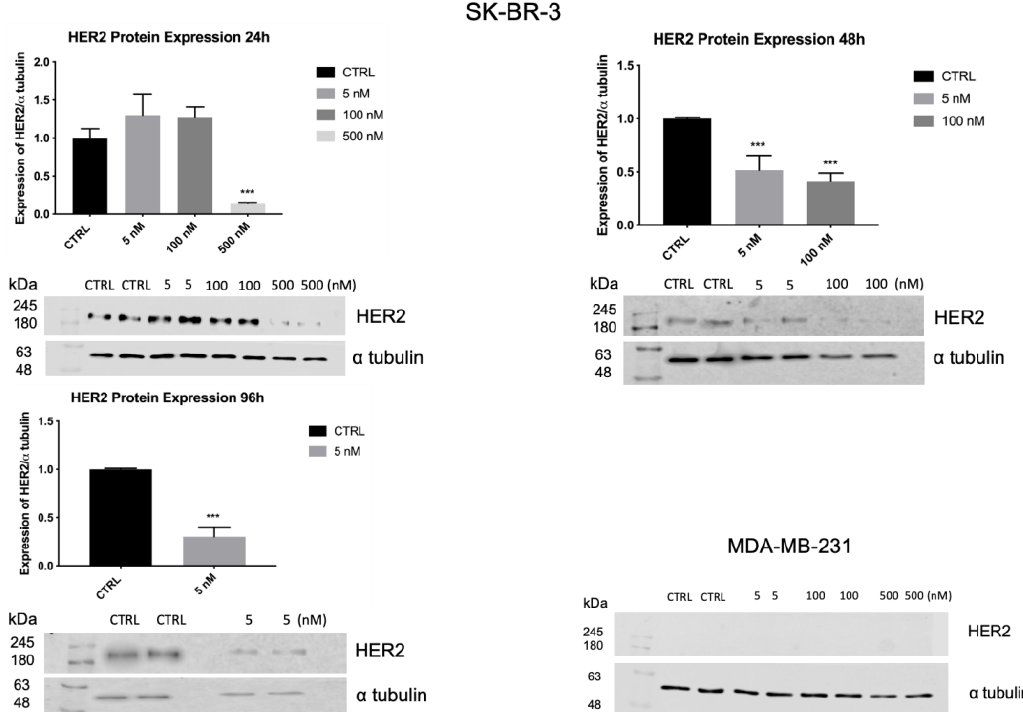
Figure 10. HER2 expression in SK-BR-3 and MDA-MB-231 cell lines. SK-BR-3 were treated for 24, 48, and 96 h, while MDA-MB-231 were treated for 24 h. HER2 expression was measured by Western blot analysis and α tubulin was used as a loading control. The p -value was determined by one-way ANOVA test with Dunnett post hoc test and considered significant for p < 0.001 *** compared to control. Data are presented as mean ± SEM. The complete western blots are shown in supplementary Figures S1 and S2.